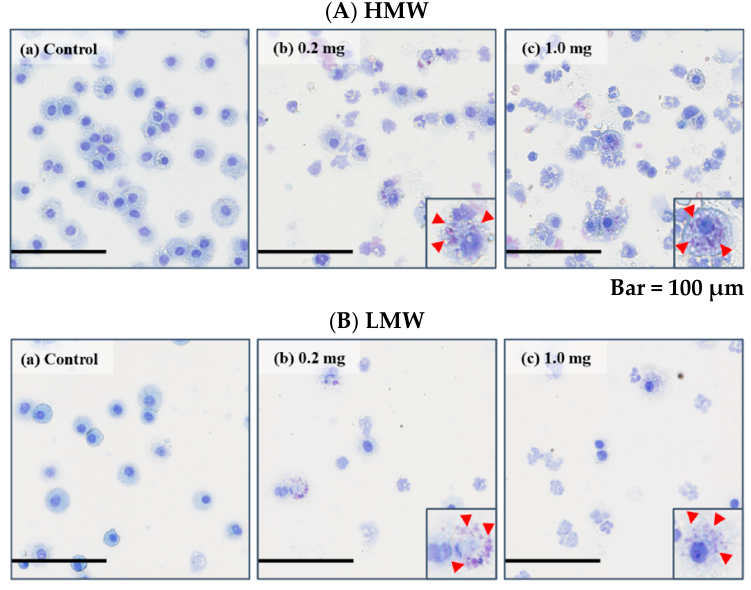
Figure 4. Cells in BALF at 3 days after the instillation. The images of cells in BALF are shown in Figure 4. ( A ) HMW PAA-exposure group and ( B ) LMW PAA-exposure group, where ( a ) control group, ( b ) 0.2 mg-exposure group, and ( c ) 1.0 mg-exposure group. Polymer phagocytosed macrophages are shown in the insets (red arrow heads). (internal scale bar = 100 µm for all).